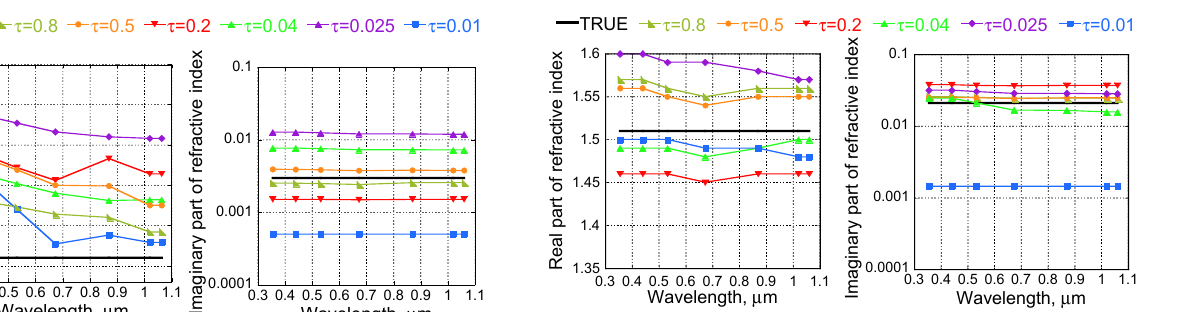
Fig. 6. Retrievals of complex refractive index of the “Urban” aerosol model under different AOT.